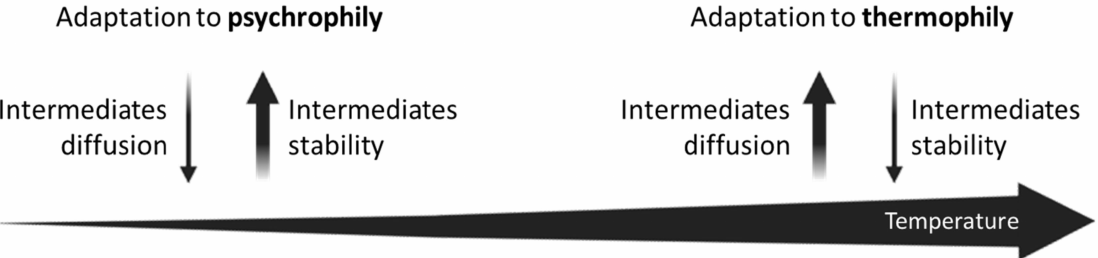
Figure 4. Low and high temperatures as divergent forces leading to the necessity for an operonic gene organization and compartmentalization of